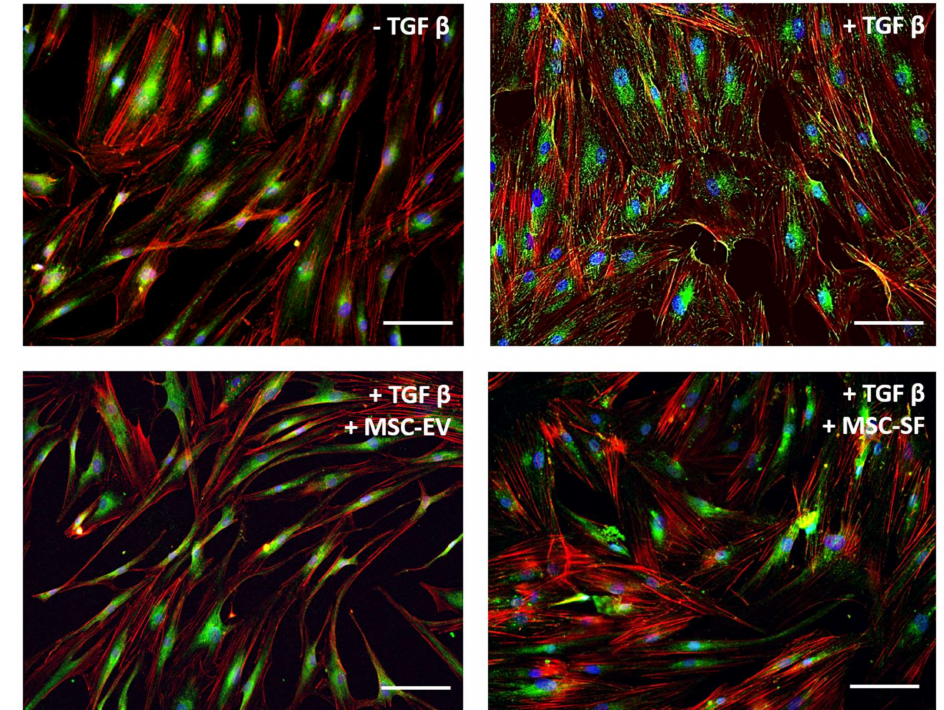
Figure 3. MSC-CM fractions added simultaneously with TGFbeta prevented the TGFbeta-induced intracellular redistribution of vinculin from perinuclear zone to the focal adhesion contact sites in fibroblasts. Immunofluorescent analysis (vinculin (green), phalloidin (red), DAPI (blue)) of the content of vinculin in serum-free cultured control fibroblasts ( − TGFbeta), in fibroblasts after exposure to TGFbeta ( + TGFbeta) and TGFbeta with the components of MSC-CM ( + TGFbeta + MSC-EV; + TGFbeta + MSC-SF). Scale bar: 100 µ